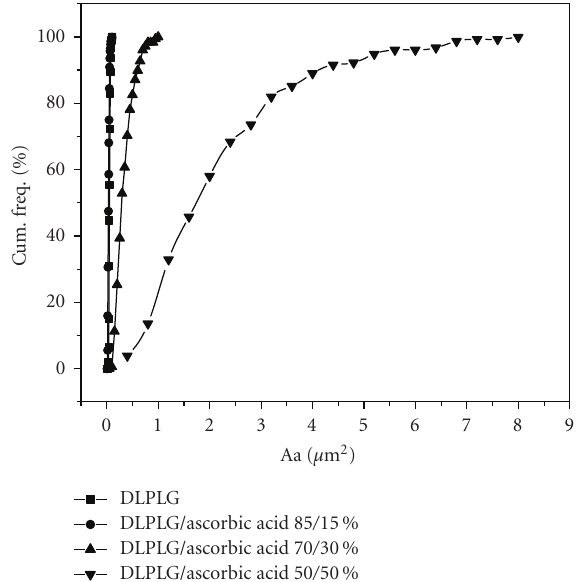
Figure 6: Comparative results of the stereological examining of DLPLG particles and particles with di ff erent ratio of DLPLG and ascorbic acid, DLPLG/ascorbic acid 85/15%, DLPLG/ascorbic acid 70/30%, DLPLG/ascorbic acid 50/50%, based on maximal diameter of the particle Dmax.